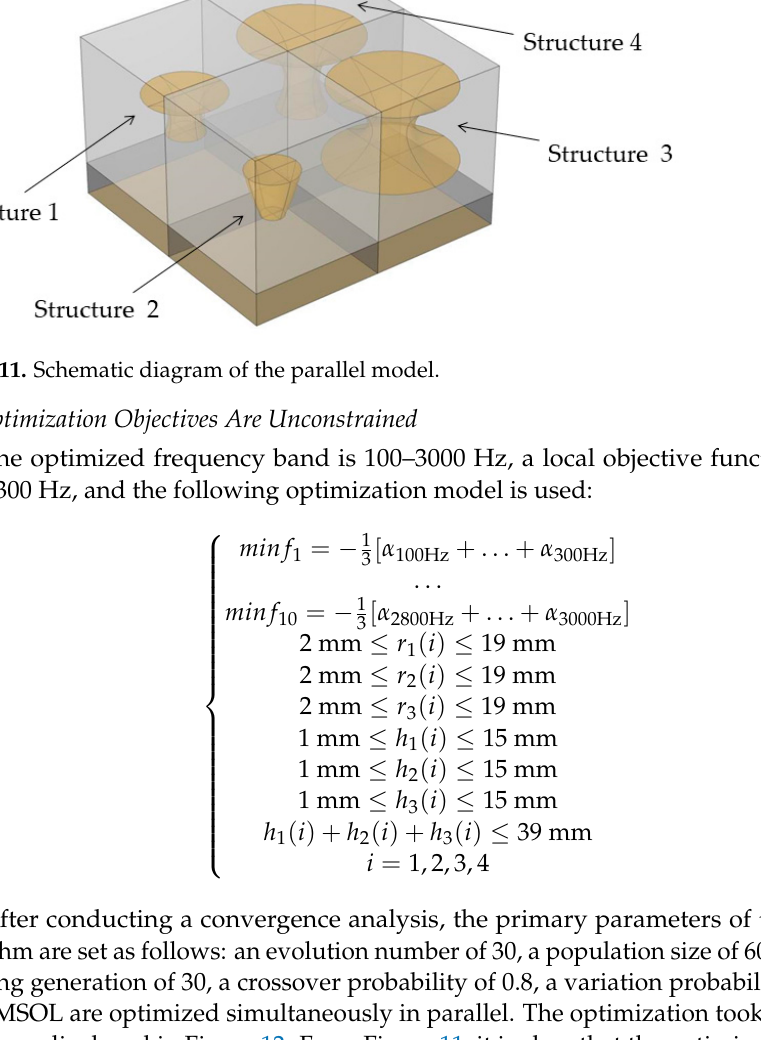
Figure 10. Optimized results, ( a ) Scheme 1; ( b ) Scheme 2; ( c ) Scheme 3.